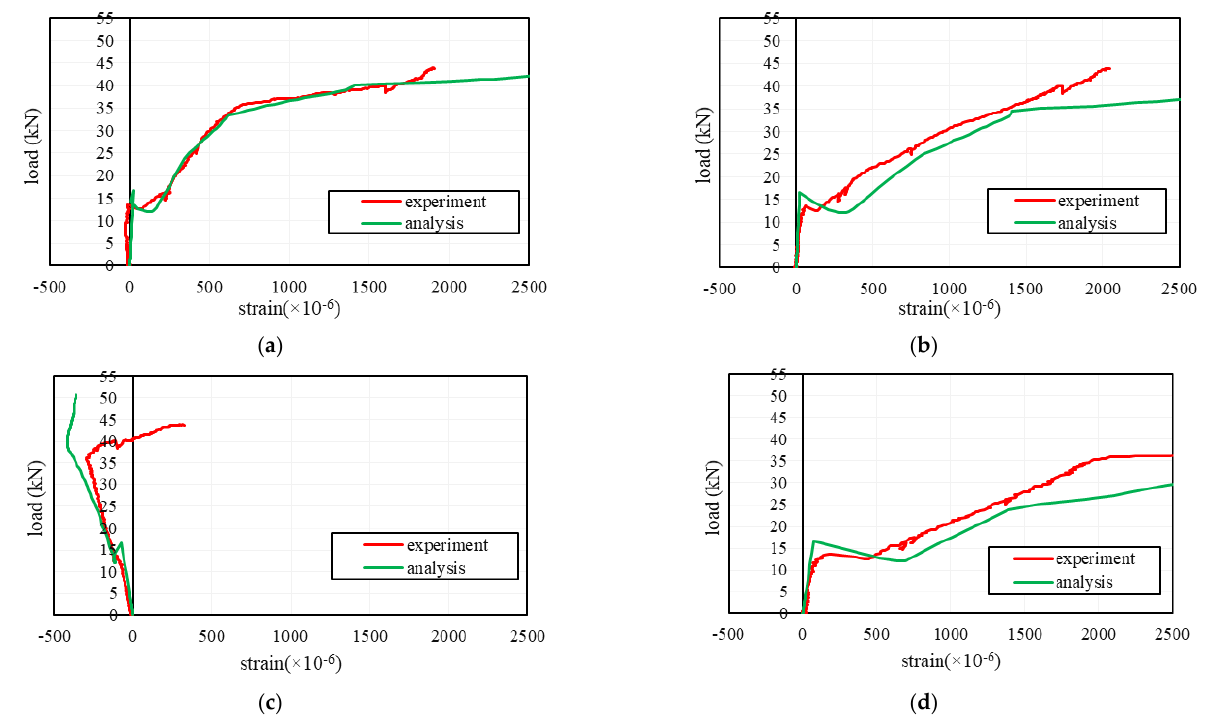
Figure 10. Load−strain relationship of each of the reinforcing bars: ( a ) compression strain of the rebar in the concrete; ( b ) tensile strain of the rebar in the concrete; ( c ) compression strain of the rebar in the PCM layer; ( d ) tensile strain of the rebar in the PCM layer.